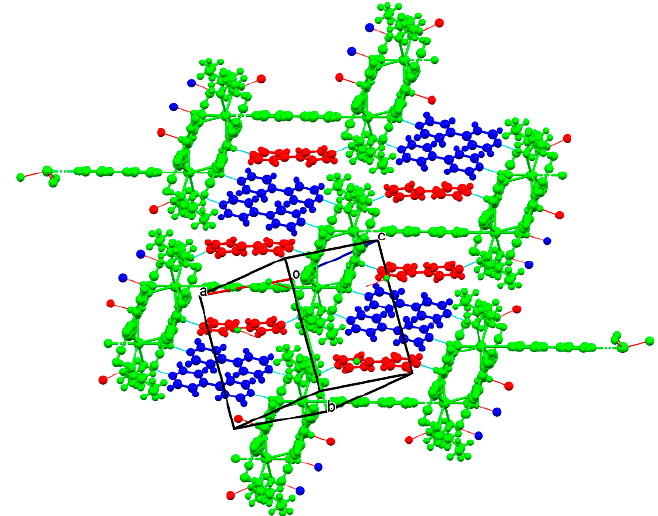
Figure 18 . The complete packing arrangement in compound 4 .